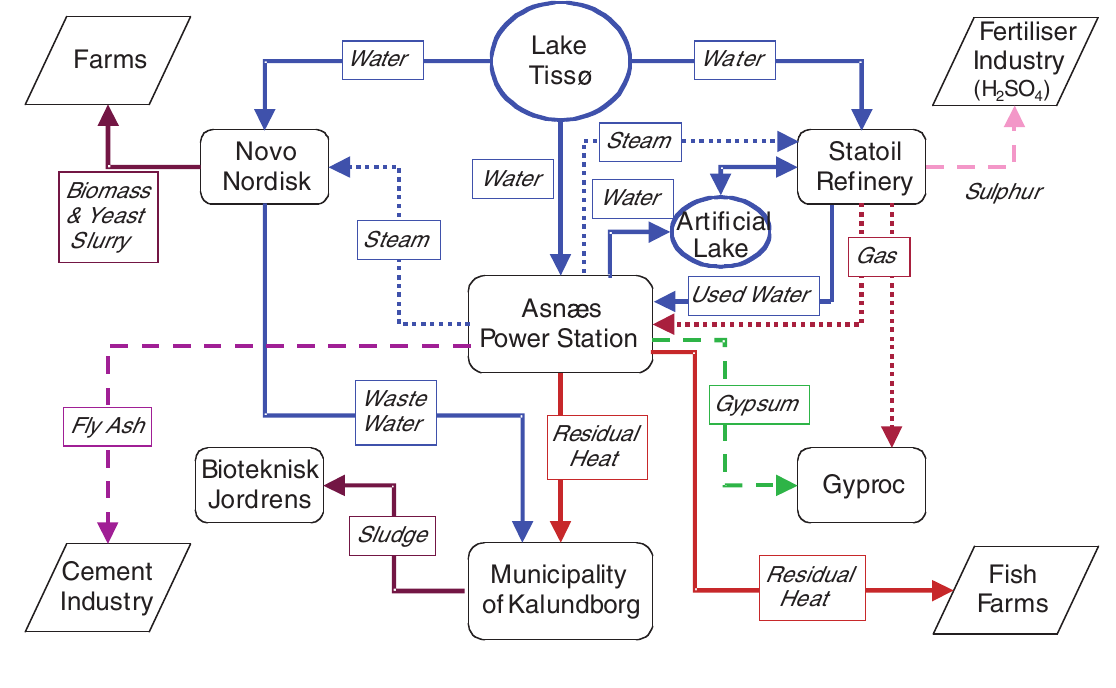
Material flows in the Kalundborg industrial ecosystem (status 1999). (Source: Colin Francis, ICAST, adapted from Jørgen Christensen, Symbio- sis Institute,